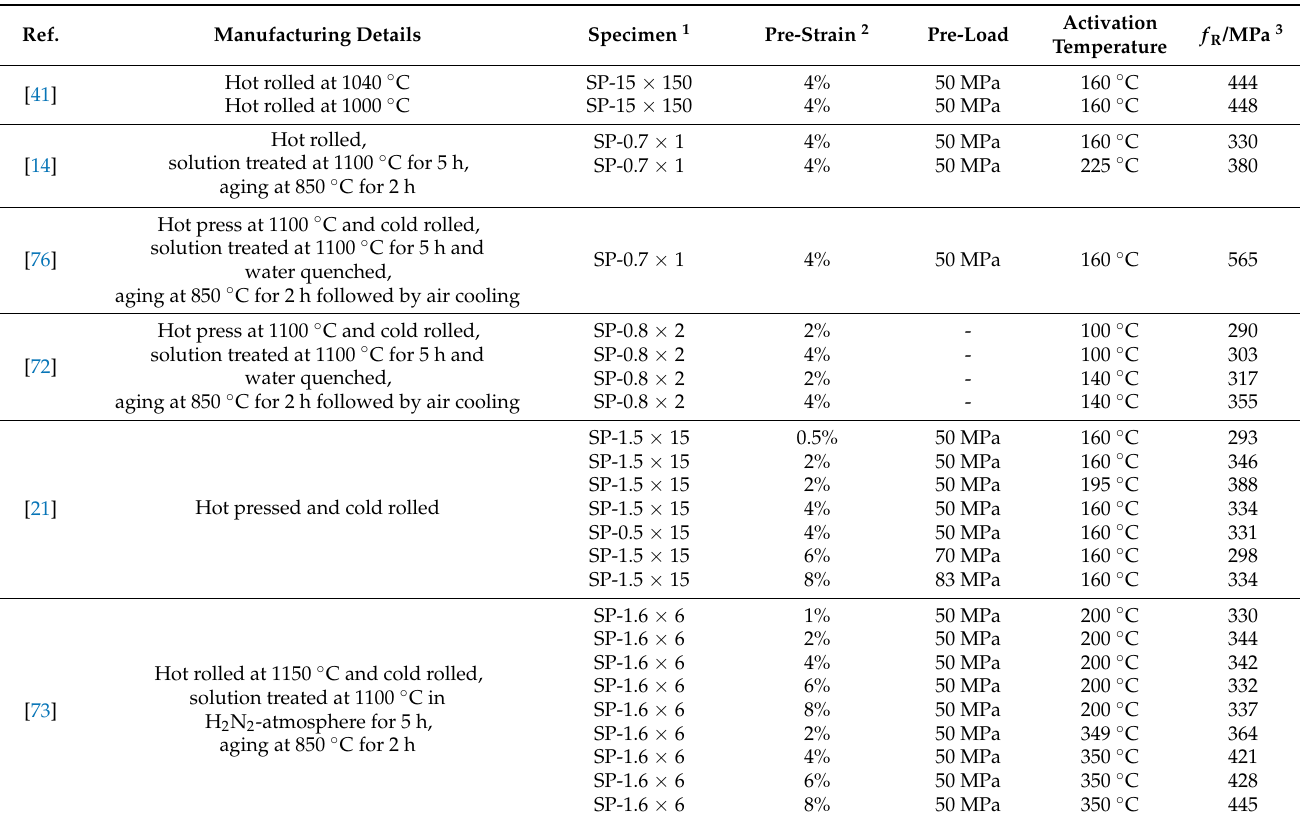
Table 4. Recovery stresses for Fe-SMA under different activation conditions.